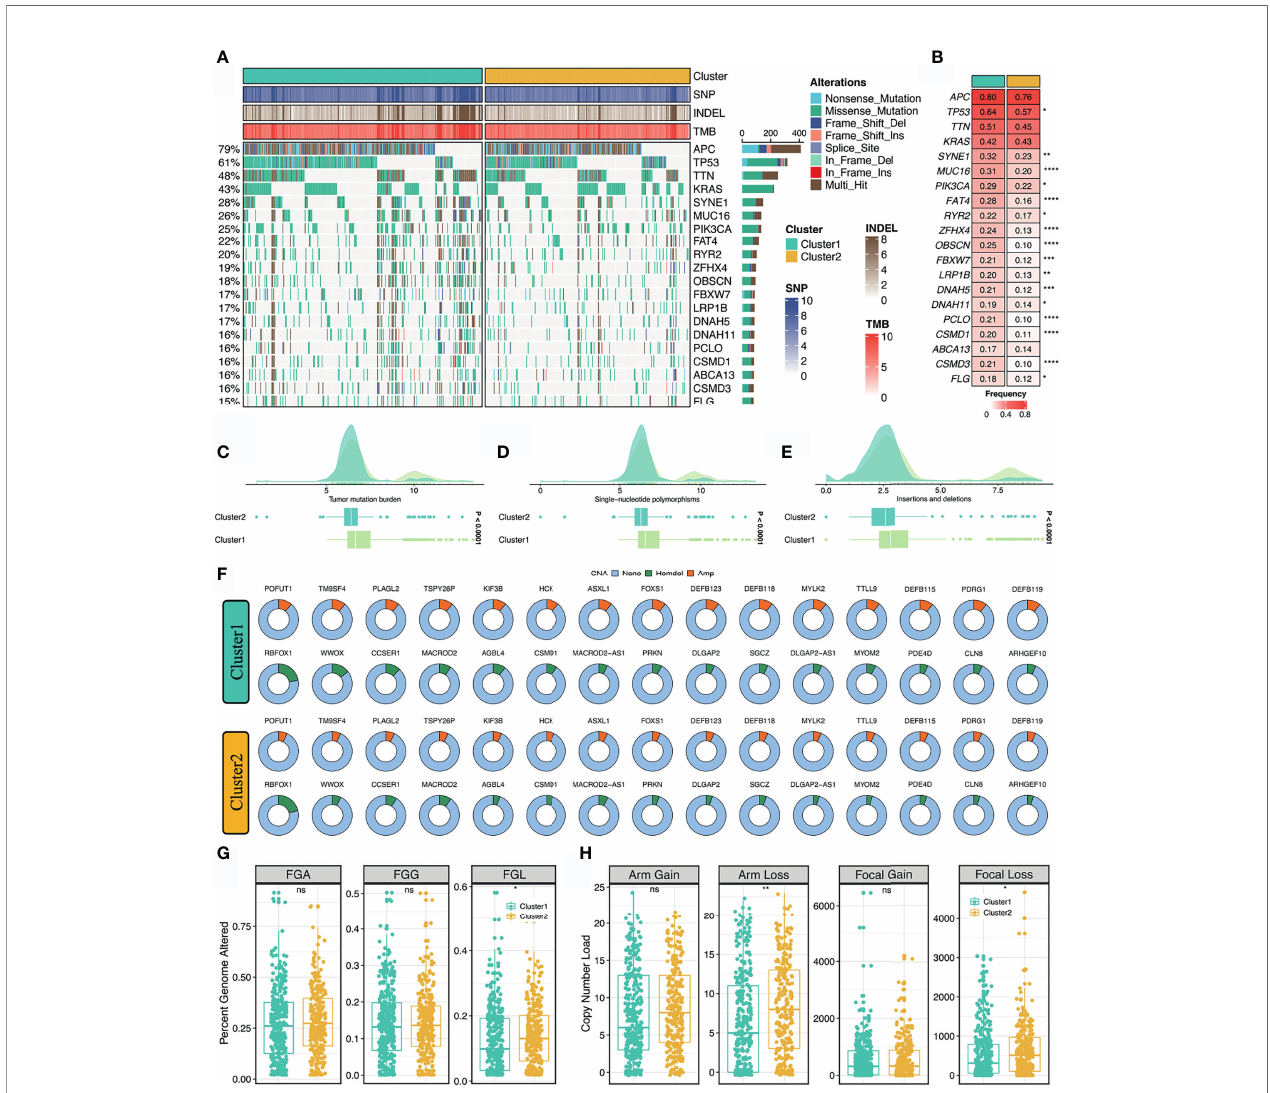
FIGURE 4 | Multi-omics landscape of the stemness clusters. (A, B) . Mutational landscape (A) and frequency (B) of the top 20 FMGs between two clusters. (C – E) Distributions of TMB (C) , SNP (D) , and Indel (E) between two clusters. (F) CNV frequency of 30 FAGs/FHGs between two clusters. (G) Distributions of FGA, FGG, and FGL between two clusters. (H) . Distributions of arm gain, arm loss, focal gain, and focal loss. ns P > 0.05, * P < 0.05, ** P < 0.01, *** P < 0.001, **** P <